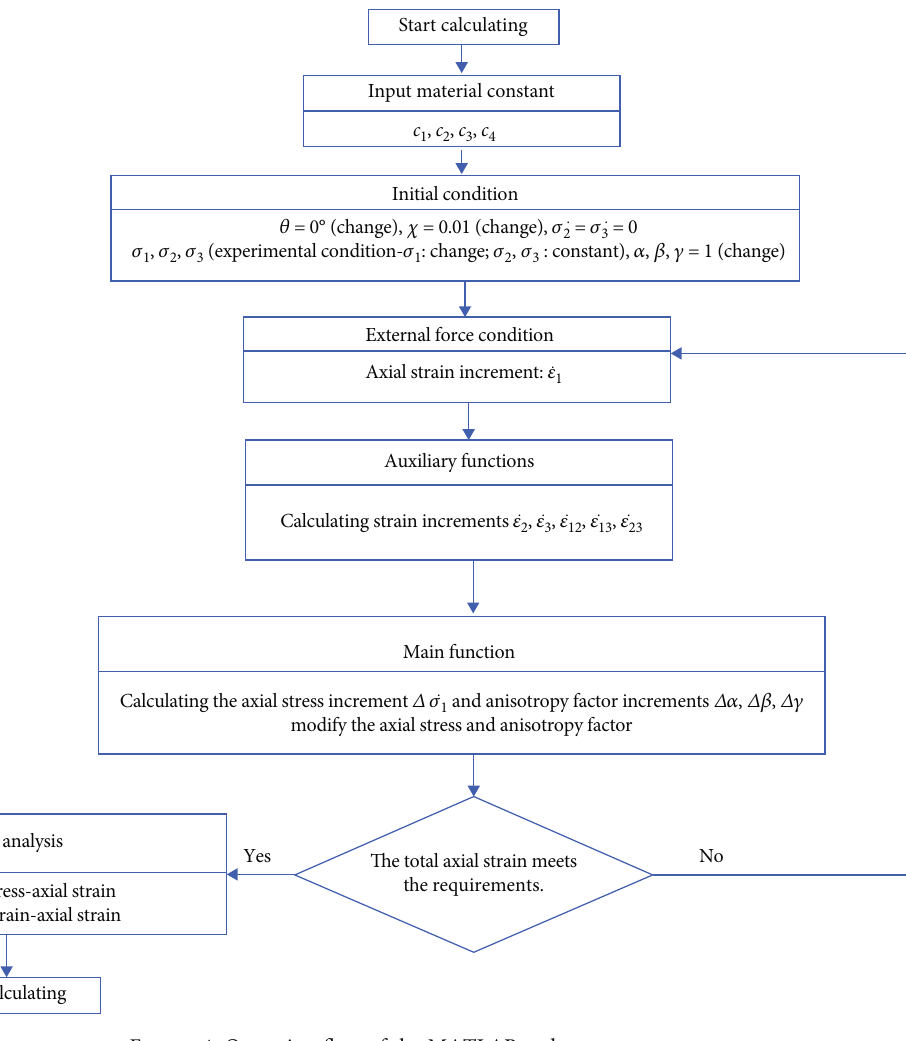
Figure 4: Operation fl ow of the MATLAB